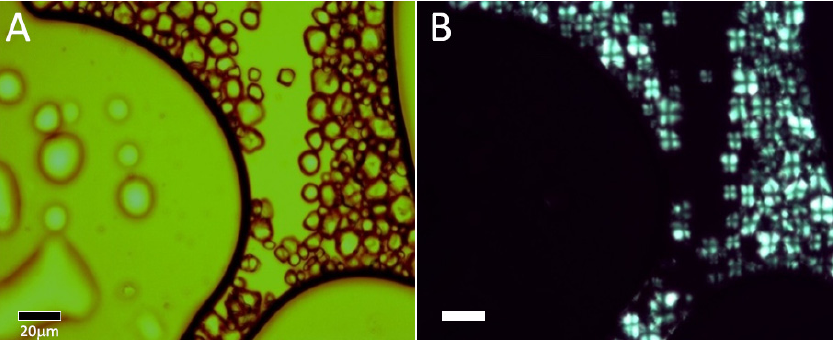
Figure 1. Optical microscopy (OM) images of starch granules under normal light ( A ) and polarized light ( B ).